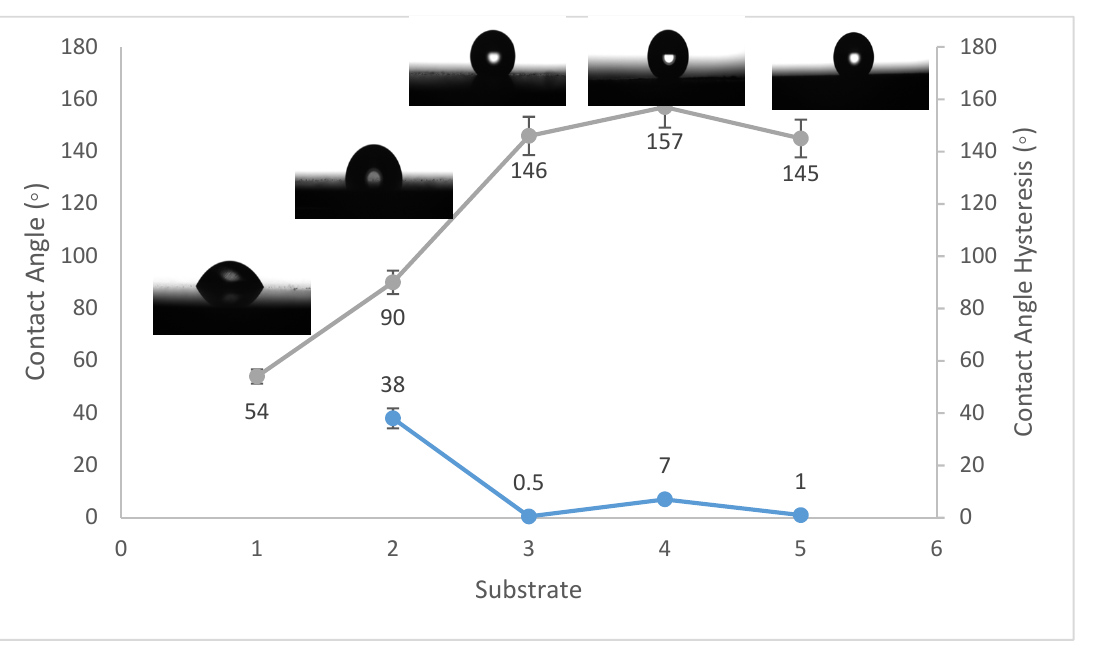
Figure 1. Wettability (WCA and WCAH) of S1, S2, S3, S4, and S5 conditions (steel substrates).